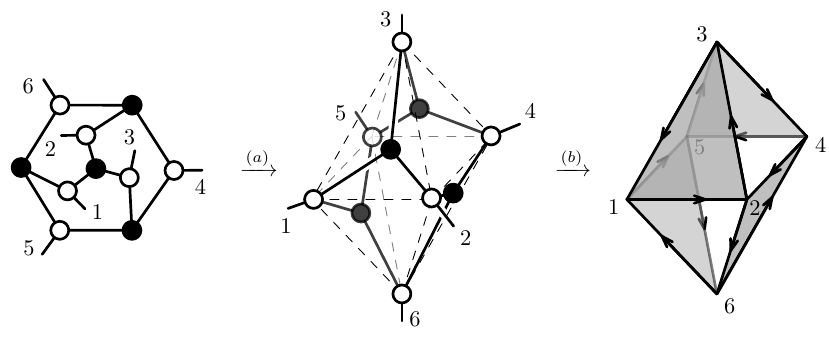
Figure 1 . Translation from an on-shell diagram to a set of triangles living on a sphere, for the example of the octahedral leading singularity associated to the set of triples T = f (1 ; 2 ; 3) ; (3 ; 4 ; 5) ; (5 ; 6 ; 1) ; (6 ; 4 ; 2) g . (a) Place black and white vertices at the faces and vertices of the octahedron respectively. (b) Associate a shaded face to each black vertex. Orientation of each face is that of the corresponding